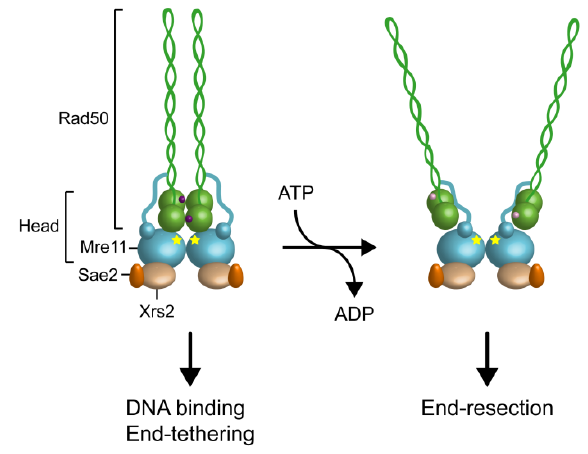
FIGURE 1: Structural organization of the MRX complex. The ATP- bound state of Rad50 negatively regulates MRX nuclease activity by masking the Mre11 nuclease sites. ATP hydrolysis by Rad50 causes conformational changes of both Rad50 and Mre11, result- ing in disengagement of Rad50 dimer and exposure of the Mre11 active sites that can access DNA to initiate DSB resection. The Mre11 nuclease sites are indicated by yellow stars. ATP and ADP are indicated by purple and pink dots,